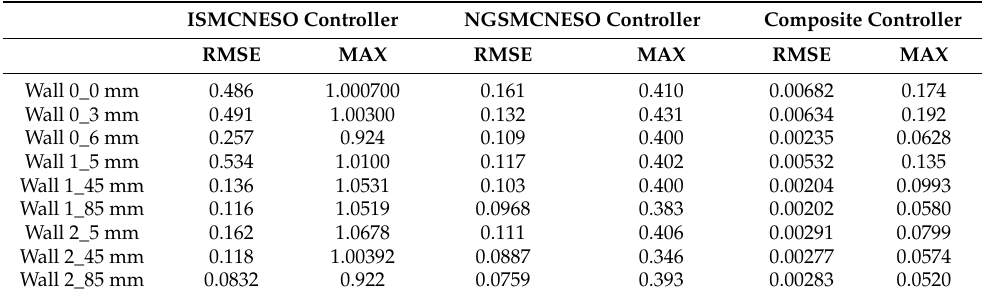
Table 8. The calculation results of RMSE and MAX.